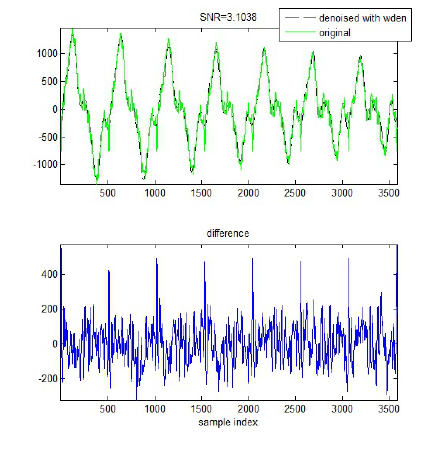
Figure 18. Descending slope, M = 0.06, denois- ing with wden. Top - MAD , bottom –